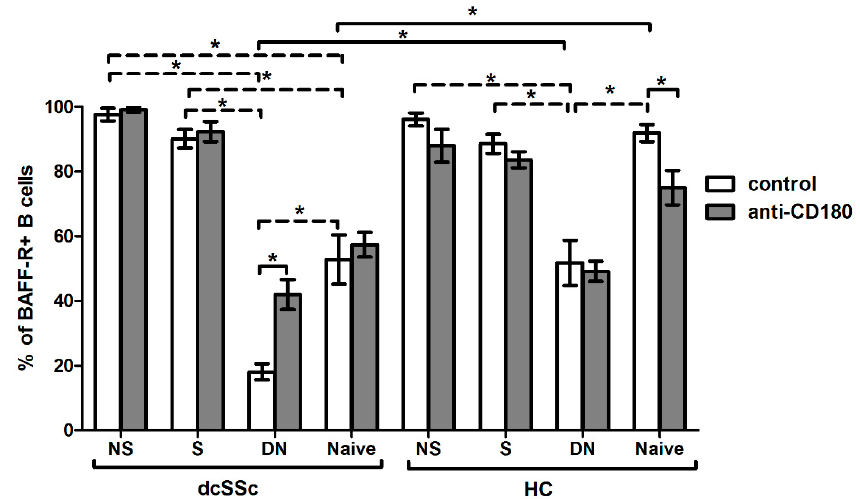
Figure 4. Effect of CD180 stimulation on BAFF-R expression of B cell subpopulations in dcSSc ( n = 4) and HCs ( n = 4). The percentage of BAFF-R-positive B cells in the four investigated B cell subsets, defined by CD27 and IgD labeling: CD27+IgD+ non-switched memory (NS), CD27+IgD- switched memory (S), CD27-IgD- double negative (DN) and CD27-IgD+ naive B cell subsets after anti-CD180 antibody stimulation or left unstimulated (control). The solid lines show significant differences between dcSSc patients and HCs, and between unstimulated and stimulated conditions, while the dashed lines indicate significant differences between unstimulated B cell subsets within groups. Data are presented as means ± SEM. * p <